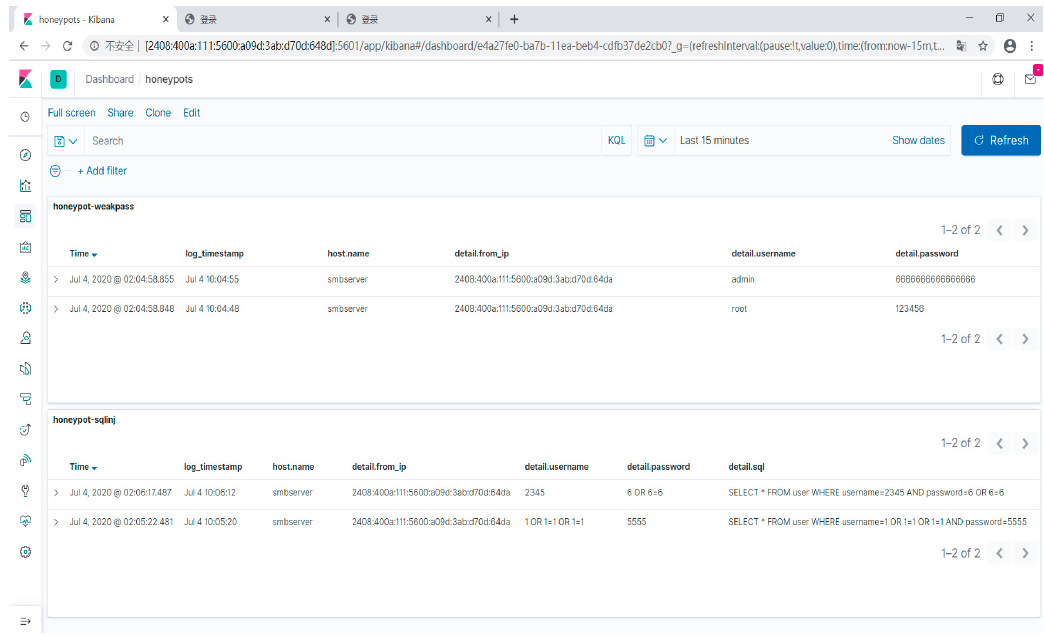
Figure 6. Visual Figure 6. Visual Display.